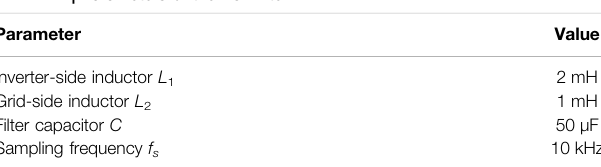
TABLE 1 | Parameters of the LCL fi